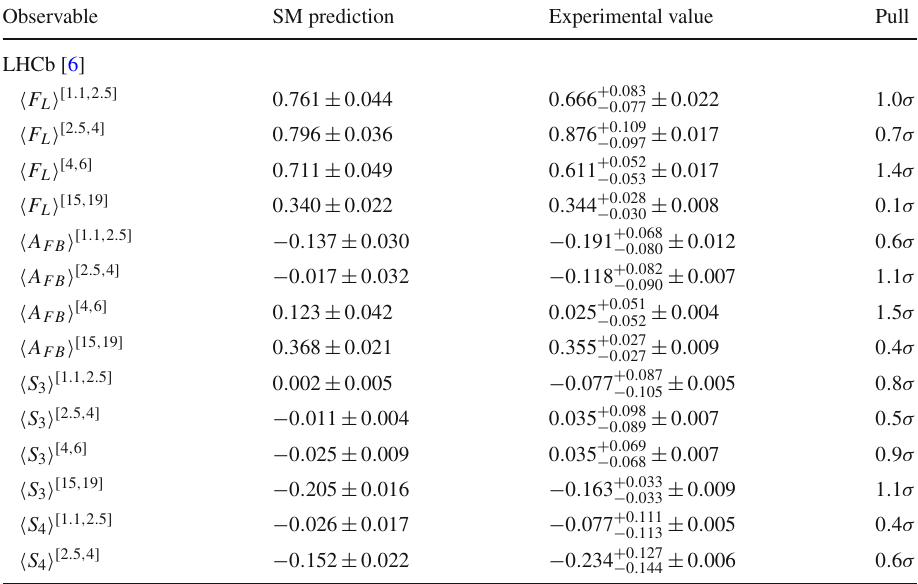
Table 7 Angular observables of B 0 → K ∗ 0 μ + μ − included in the global